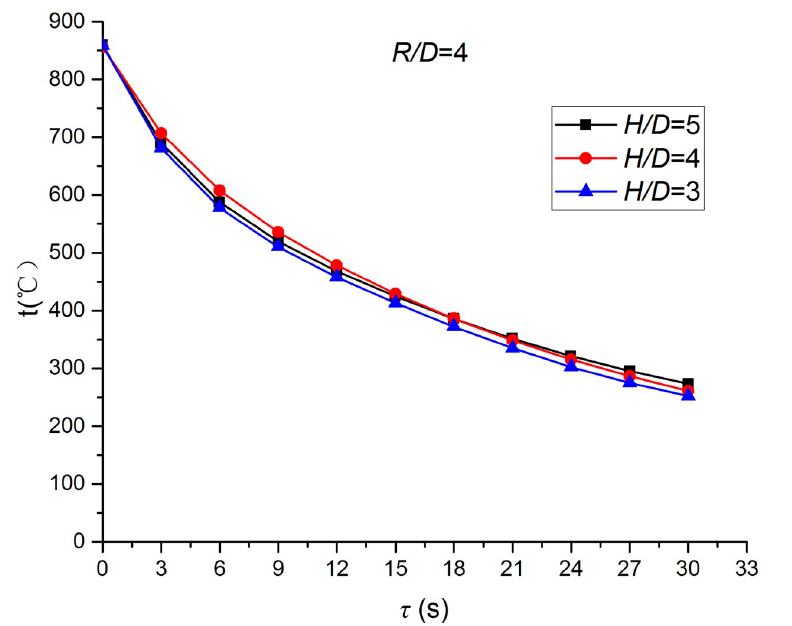
Fig 29. Surface temperature at R/D =